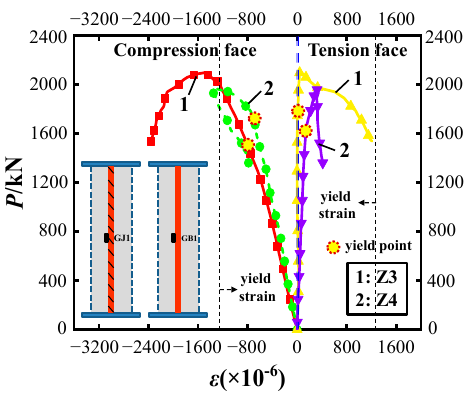
Figure 12. Comparison of load–strain curves of reinforcement and vertical plate.